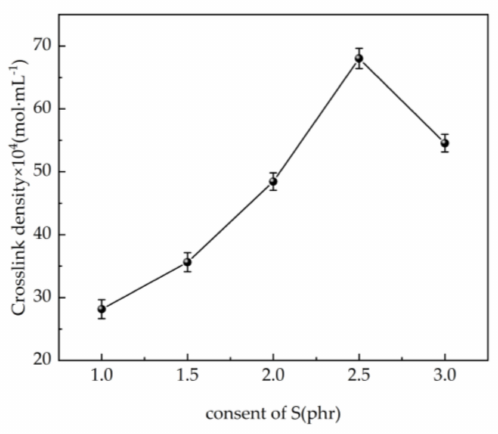
Figure 19. Relationship between the content of S and cross-link